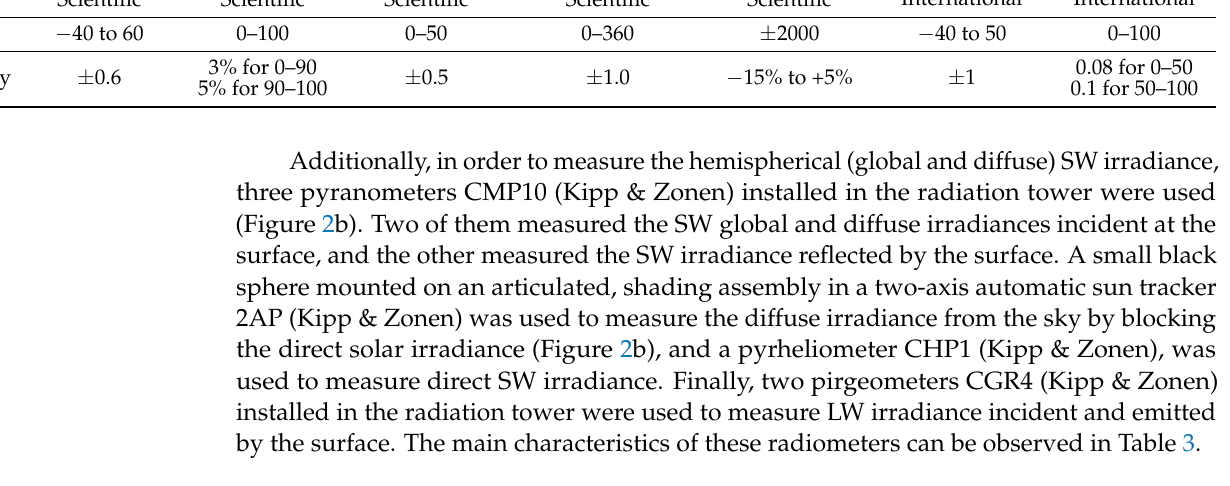
Table 3. Main characteristics of the radiation instrumentation installed in the